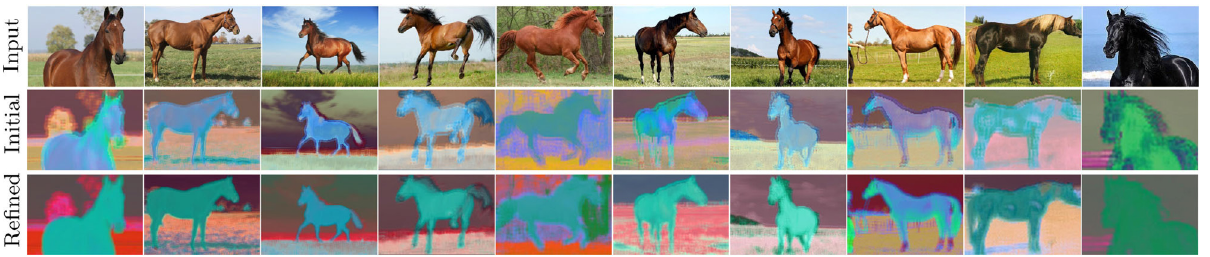
Fig. 8 Refining the embeddings to the Horse domain. Above, we demonstrate the embeddings before and after the domain specialization stage. As shown, and quantitatively stated in Table 2, the embeddings of the objects (e.g., the horses) are more coherent after refinement.